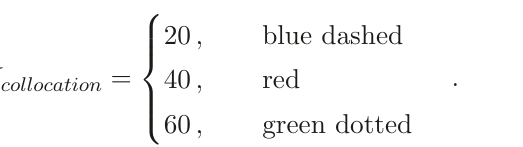
and operators in sBBL model with g = O i O r < crit . Different color coding represents different spatial E E